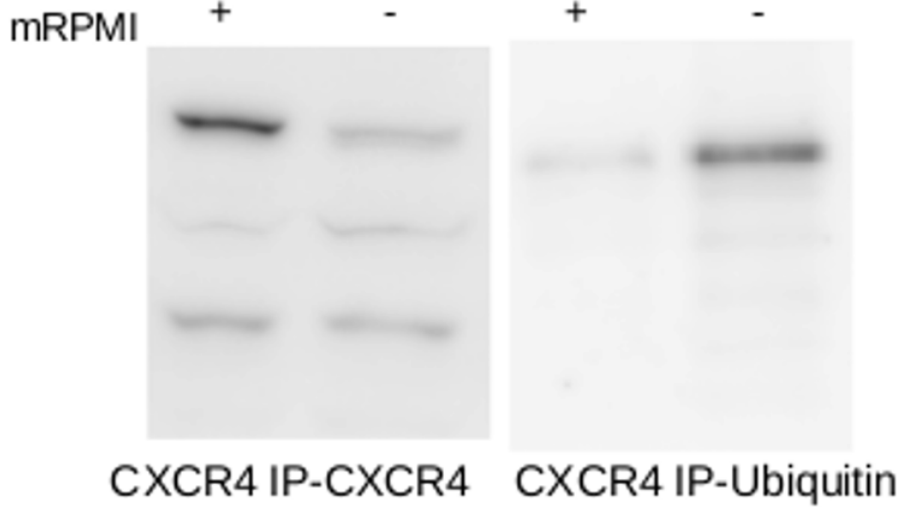
Fig 8. Effect of mRPMI on CXCR4 ubiquitination. CXCR4 immune precipitates from serum-starved (control) and mRPMI treated SK-N-SH cells were subjected to western blot analysis. Protein detection was carried out using anti-ubiquitin antibody. Shown is the representative result from 3